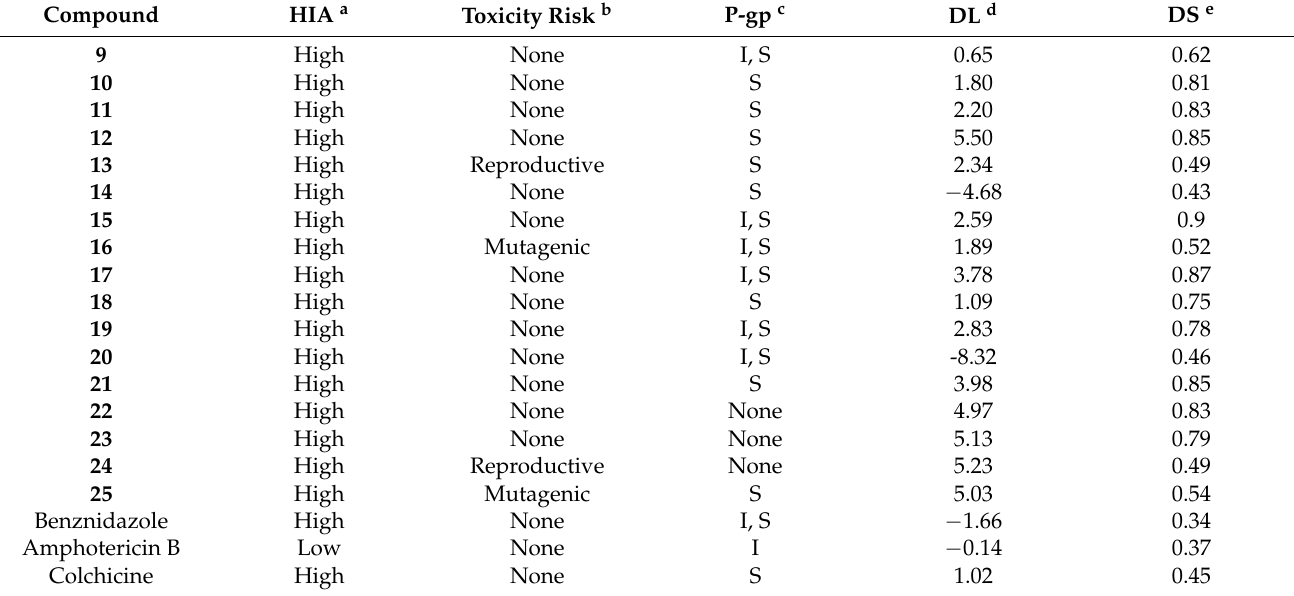
Table 7. Pharmacokinetic and toxicity in silico prediction of compounds 9 – 25 and reference